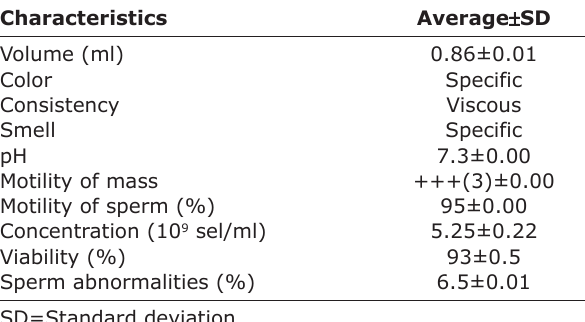
Table-1: Evaluation of fresh rooster spermatozoa